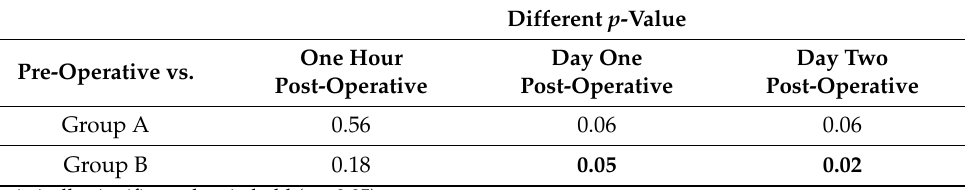
Table 4. Rho Spearman’s correlation between Surgical Time and Hemoglobin serum level at different times for study group. Spearman’s Rank Surgical Time p -Value Correlation Coefficient Pre-operative hemoglobin (g/dL) 0.39 − 0.12 Hour One Post-operative hemoglobin (g/dL) 0.02 − 0.33 Day One Post-operative hemoglobin (g/dL) 0.04 − 0.29 Day Two Post-operative hemoglobin (g/dL) 0.08 − 0.25 Statistically significant data in bold ( p < 0.05). Table 5. Differences between pre-operative and post-operative Alhazzani scores within each study group (Wilcoxon test). Different p -Value Pre-Operative vs.